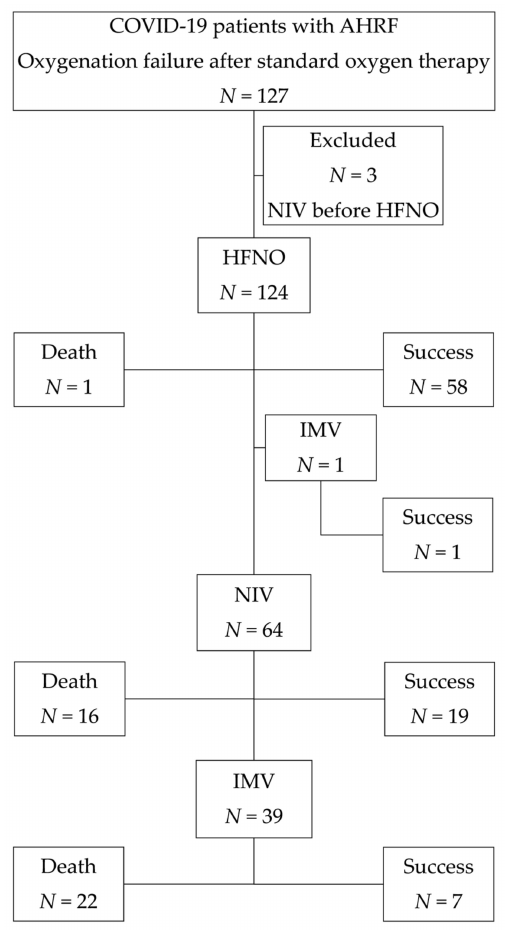
Figure 1. The flow of screening and patient inclusion. AHRF: acute hypoxemic respiratory failure; HFNC: high-flow nasal cannula; NIV: non-invasive ventilation; IMV: invasive mechanical